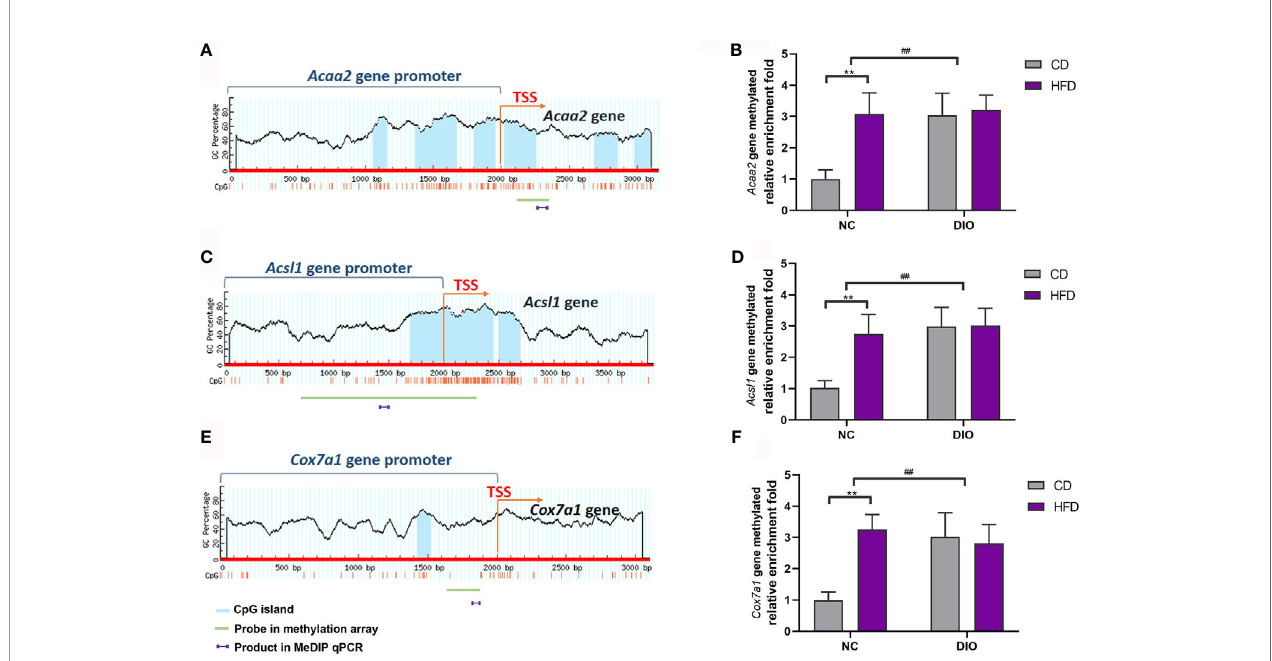
FIGURE 7 | The effect of maternal HFD activated the gene methylation of Acaa2 , Acsl1 , and Cox7a1 promoter in male offspring BAT. Diagram showed the CpG island region in promoters and transcriptional starting site (TSS) shores of (A) Acaa2 , (C) Acsl1 , and (E) Cox7a1 . The methylation changes of (B) Acaa2 , (D) Acsl1 , (F) Cox7a1 quanti fi ed by MeDIP-qPCR in BAT. Values represent the mean ± SEM, n = 8 each group. P values represent signi fi cance in the main effect for each source of variation (diet or prenatal exposure) as calculated by two-way ANOVA: ** P < 0.01 offspring diet effect, ## P < 0.01 maternal diet effect. NC, normal control; DIO, diet-induced obesity; CD, control diet; HFD, high-fat diet.